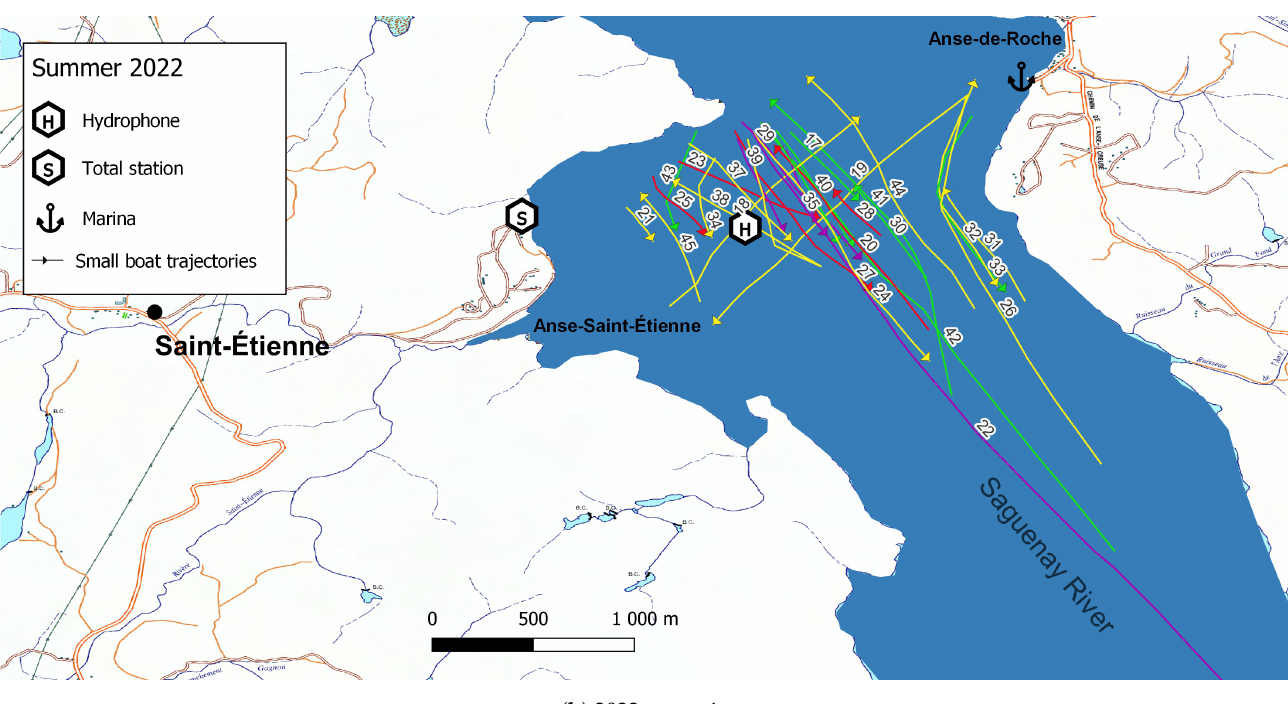
Figure 1. Zone of interest along the Saguenay River. Positions of the shore-based Leica TS06 total station, hydrophone, and marina at Anse-de-Roche are identified. Trajectories followed by 45 isolated recreational vessels during the summers of ( a ) 2021 and ( b ) 2022 are shown. Trajectories are colour- coded according to the vessel’s type: red for Zodiac TM , yellow for speedboats, green for cruisers, and purple for sailboats. Labels refer to individual entry lines in Table